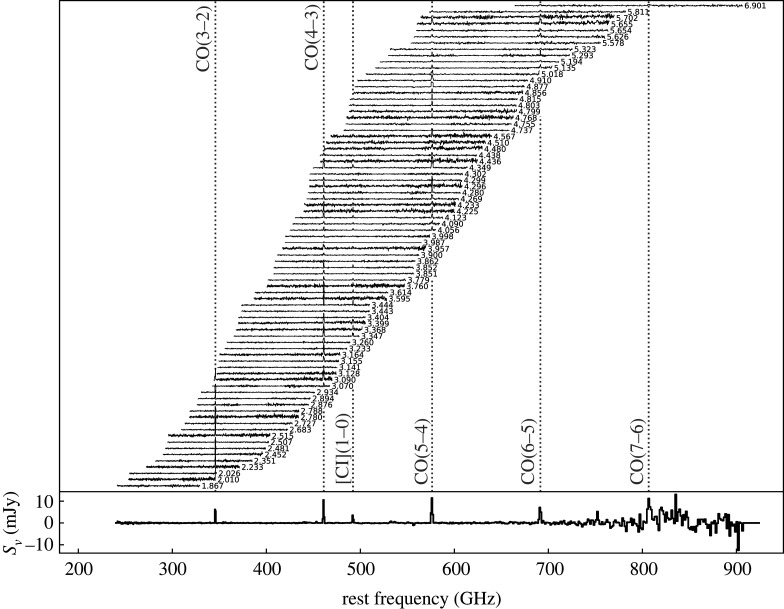
ALMA 3 mm spectra of 78 SPT sources from Reuter et al. [191]. Spectra are continuum subtracted and offset for clarity. Each spectrum is labelled with the derived ALMA redshift. Such work on strongly lensed sources has helped demonstrate ALMA’s utility as a redshift machine for bright dusty sources at high-redshift. The bottom panel shows the stacked spectrum. Figure courtesy of C. Reuter and the SPT Collaboration.